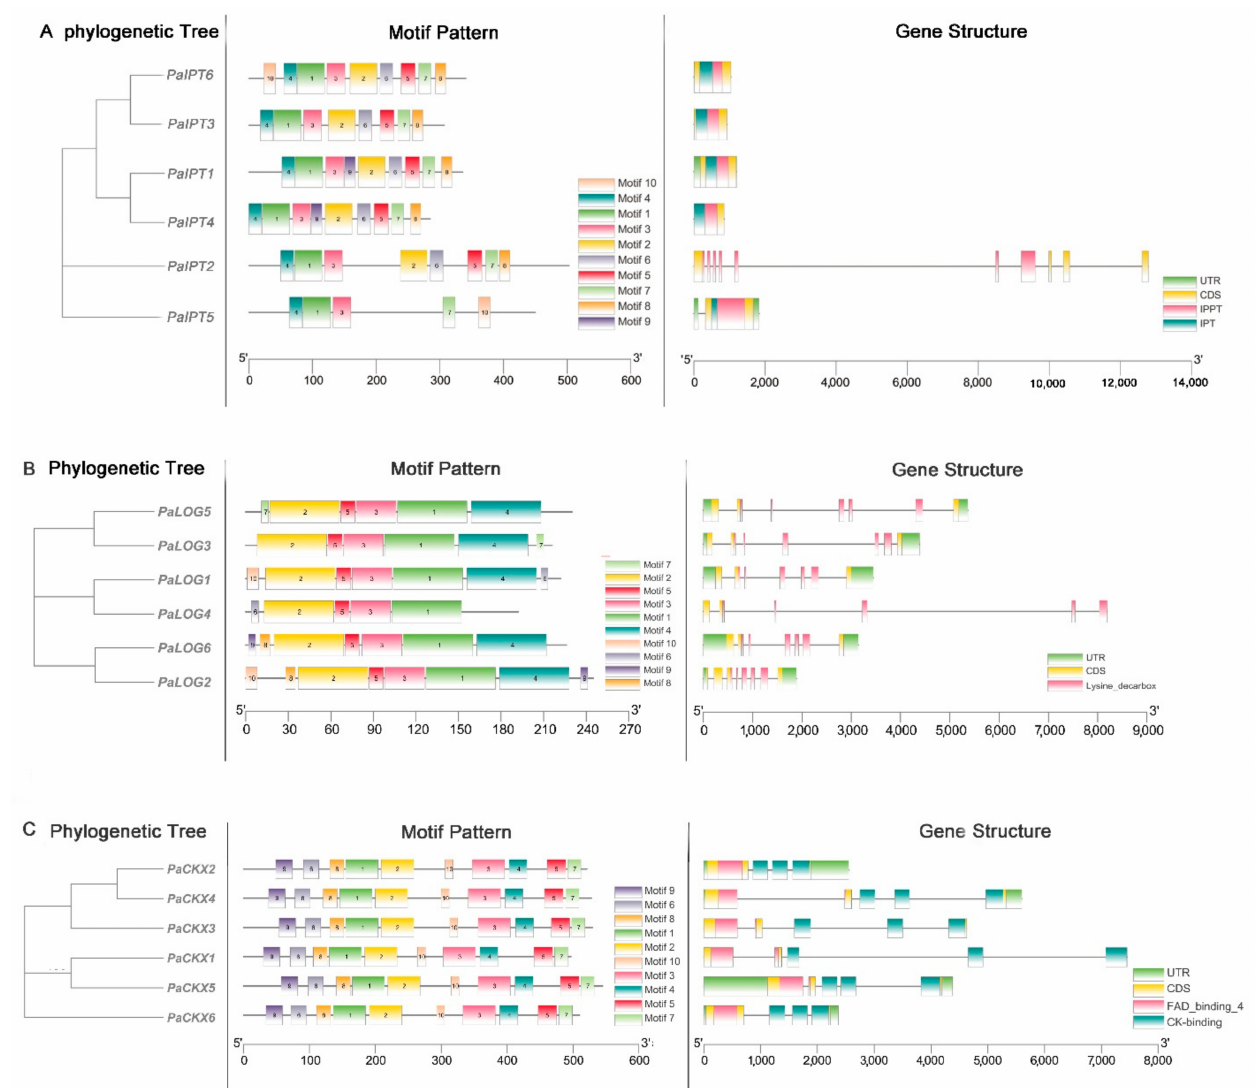
Figure 1. The gene structure, motifs distribution, and phylogenetic relationship of PaIPTs ( A ), PaLOGs ( B ), and PaCKXs ( C ). For phylogenetic tree, the analyses were constructed based on protein sequences using MEGA-X software. For conserved motif analyses, the motifs are presented in different colored boxes with numbers 1–10. The length of gene can be estimated using the scale at the bottom. For gene structure analyses, green boxes indicate untranslated 5 (cid:48) - and 3 (cid:48) -regions, yellow boxes indicate exons, and black lines indicate introns. The IPPT, Lysine_decarbox, and FAD_binding_4 domain are highlighted by red boxes with IPT and CK-binding domain in dark